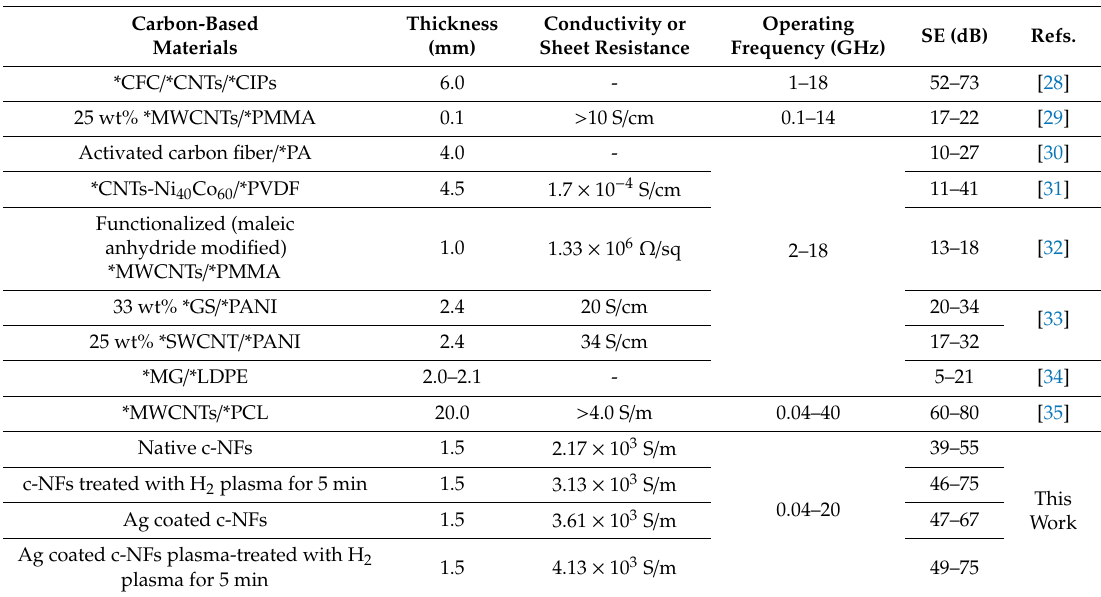
Table 5. Previously reported shielding e ff ectiveness (SE) values of carbon-based materials. Carbon-Based